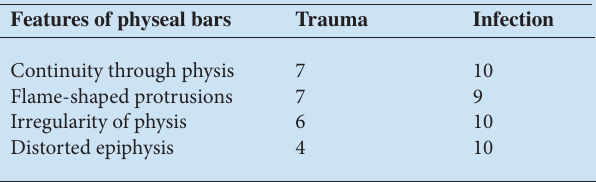
Table II. Distribution of